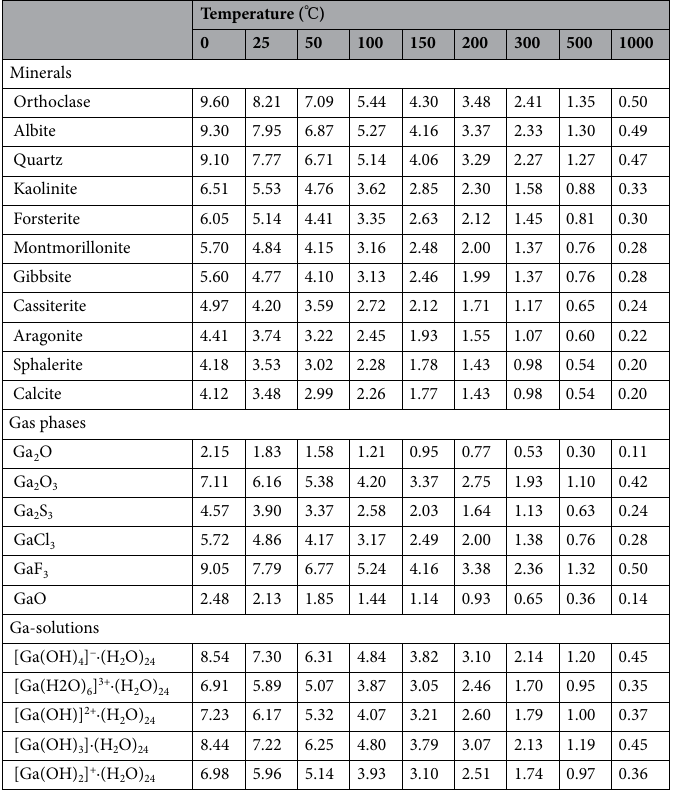
ature range of 0–300 °C can be obtained from Table 1. The 10 3 lnRPFR values of two different caution cites of for- sterite at different temperatures were shown in Table S3. The scaling factors were not used for all eleven minerals. Fractionation factors of Ga‑bearing minerals. Taking the 10 3 ln(RPFR) values of different Ga-bearing minerals at 25 °C as an example, the maximum isotopic fractionation values between these minerals can reach 4.73 ‰ (isotopic fractionation factors between orthoclase and calcite). The central atoms of these different solid minerals were substituted by Ga as research objects. The results show that the Ga isotope enrichment sequence for these minerals is: orthoclase > albite > quartz > kaolinite > forsterite > montmorillonite > gibbsite > cassiterite > arago- nite > sphalerite > calcite. Ga isotope fractionation between these minerals decreases with increasing tempera- ture. The isotopic fractionation factor between orthoclase and calcite can reach 3.18 per mil even at 100 °C. Therefore, the isotopic fractionation of Ga isotopes can be significantly fractionated between these Ga-bearing minerals. The 10 3 ln(RPFR)s of these 11 Ga-bearing minerals varies with temperature, as shown in Fig. 5. Among these Ga-bearing minerals, silicate minerals show the strongest ability to enrich heavy Ga isotopes ( 71 Ga). This ability is related to the strength of the chemical bonds formed between Ga and negatively charged atoms (Fig. 6). In other words, the chemical bonds formed between aluminosilicate and Ga are strongest. The 10 3 ln(RPFR)s of Ga‑bearing gas phases. Ga 2 O, Ga 2 O 3 , Ga 2 S 3 , GaCl 3 , GaF 3 and GaO, were chosen to rep- resent the isotope compositions of Ga-bearing gas phases. Table 1 shows the 10 3 ln(RPFR) values of potential Ga-bearing gas phases at different temperatures. Table 2 presents the polynomial expansions of the RPFR factors ( 71 Ga/ 69 Ga) of different Ga-bearing species based on the function 10 3 lnRPFR = ax + bx 2 + cx 3 , with x = 10 6 /T 2 (T is the temperature in Kelvin). Figure 7 illustrates the 10 3 ln(RPFR) values of different Ga-bearing gas species as a function of temperature. The scaling factors were not used for the six gas phases. The 10 3 ln(α)s for pairs of Kln‑solutions. In this study, the isotopic fractionation factors between kaolinite (Kln) and aqueous solutions are given in Table 3. The Ga isotope fractionation factors between other Ga-bearing min- erals and aqueous solutions can also be obtained by using this method and shown in Table S4. The general trend of isotopic fractionation between kaolinite and aqueous solution is that the Ga-bearing aqueous solutions are enriched in heavy isotopes relative to kaolinite. The Ga fractionation factors for 5 Kln-solution pairs is decreas- ing in the order of Kln-[Ga(H 2 O) 6 ] 3+ ·(H 2 O) 24 > Kln-[Ga(OH) 2 ] + (H 2 O) 24 > Kln-[Ga(OH)] 2+ ·(H 2 O) 24 > Kln- [Ga(OH)